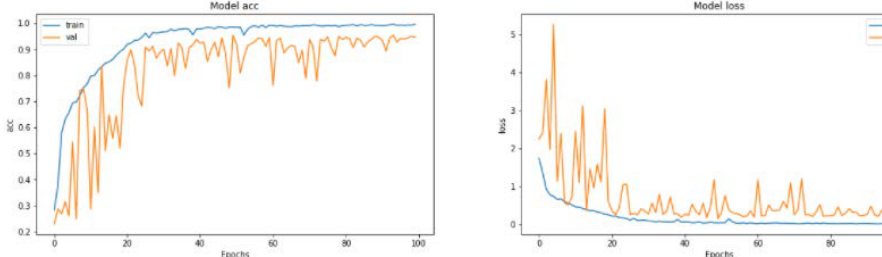
Figure 16. Trend of the Metrics During Training.